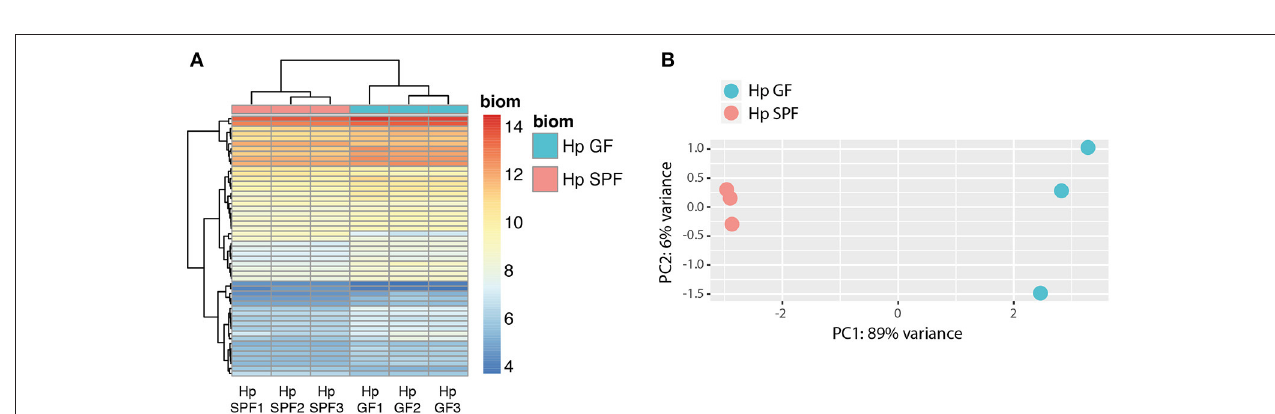
FIGURE 2 | Principle component analysis (PCA) and clustering of differentially expressed genes (DEGs). (A) Unsupervised clustering heatmap of differentially expressed genes (DEG, n = 52) in H. polygyrus samples isolated from SPF and GF mice. Red intensity indicates high gene expression, whereas blue intensity indicates low gene expression. (B) Principle component (PC) analysis revealed that 89% of the data variation is explained by the difference between SPF and GF isolates. Data are from one experiment with three biological